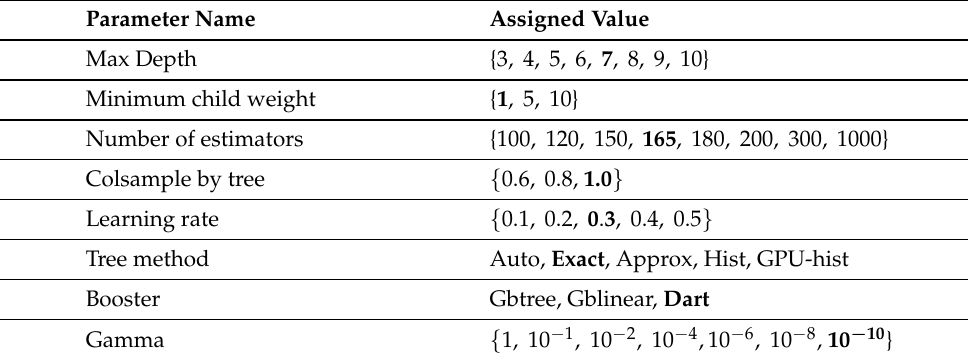
Table 3. XGBoost hyperparameters and tested